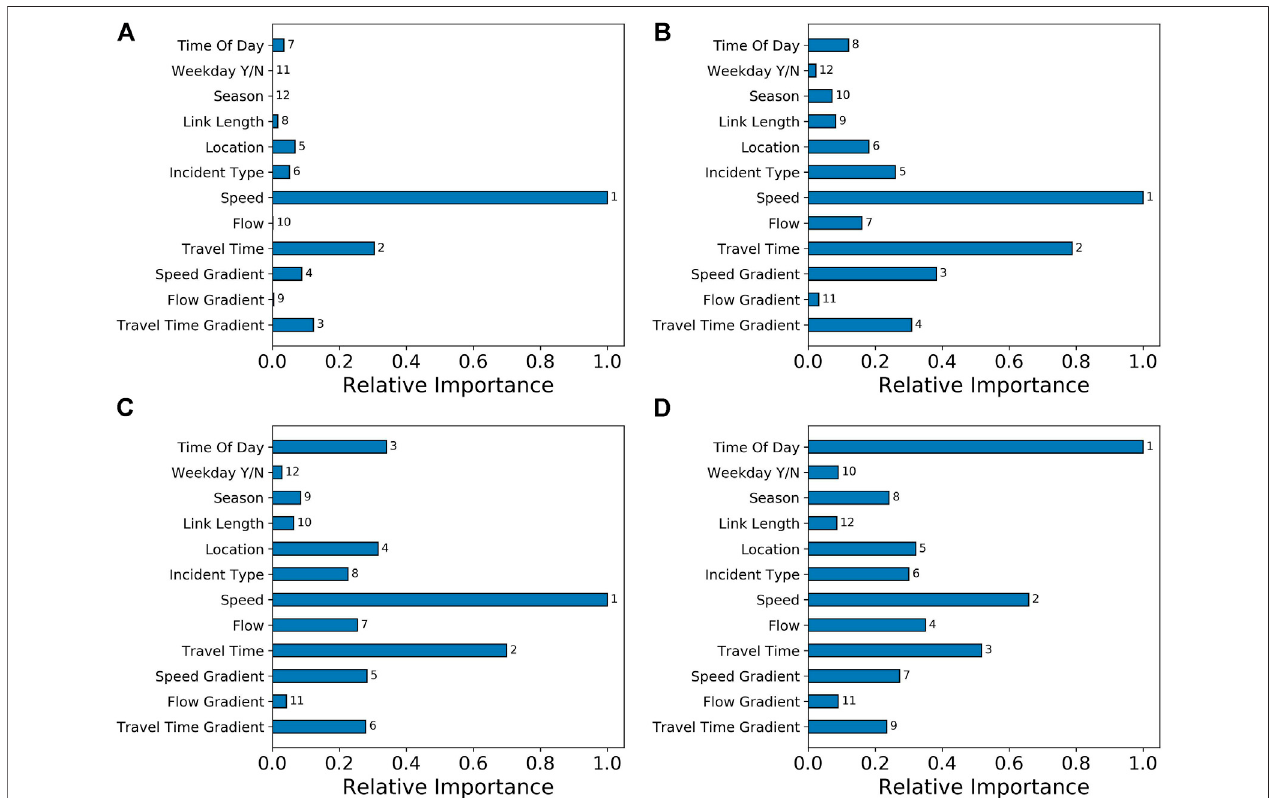
FIGURE4| Variableimportance,asmeasuredfortherandomsurvivalforestmodel,forasubsetoftheimportantvariables.Eachplotisadifferentpredictionhorizon h , all shown are at a prediction time of t (cid:2) 30. The importance at each prediction horizon has been normalized such that the largest importance at any time is 1, and all others are relative to this. The rank of each variable at a given time is written beside each bar. Due to the scaling, one should focus on the ranking and relative difference between bars in each plot. (A) : h (cid:2) 5. (B) : h (cid:2) 30. (C) : h (cid:2) 60. (D) : h (cid:2) 180.